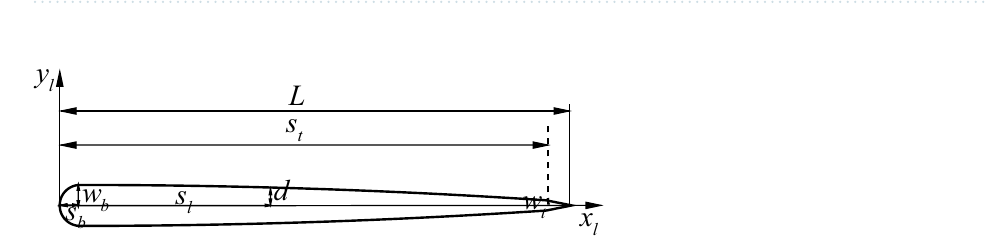
Figure 4. Geometry of a self-propelled anguilliform swimmer.